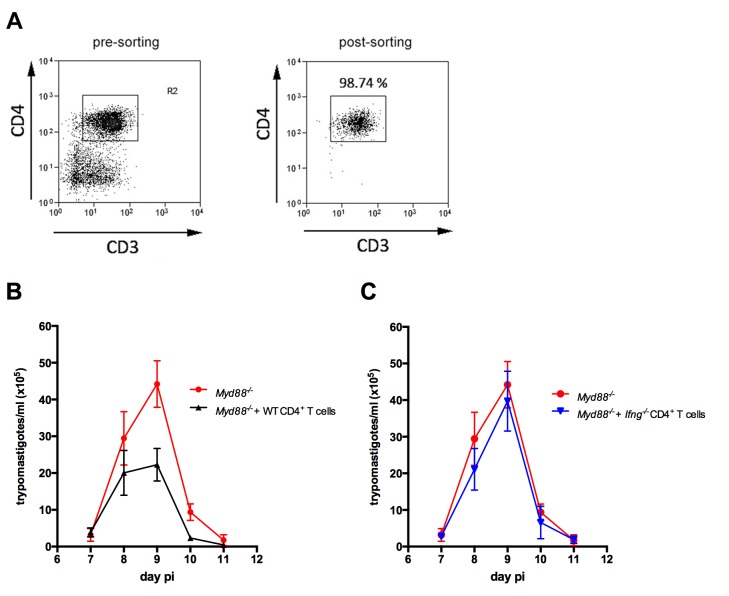
Adoptive transfer of WT, but not of Ifng−/−CD4+ T cells diminished parasitemia in infected Myd88−/− mice.(A) Sorting of CD4+ T cells: Representative frequency of CD4+CD3+ T cells after enrichment by negative selection with magnetic beads (pre-sorting, left) followed by FACS sorting (post-sorting, right), as described in Materials and Methods. Post-sorted cells (>98% pure) were employed in the adoptive transfer experiments shown in Figure 8. (B–C) Mean parasitemia in Myd88−/− mice, which received or not 1.0 × 106 CD4+ T cells (sorted as in A), purified from infected (B) WT (B6) or (C) Ifng−/− mice. Data are representative of 2 independent experiments; error bars = SEM; (n = 5 male mice individually analyzed).